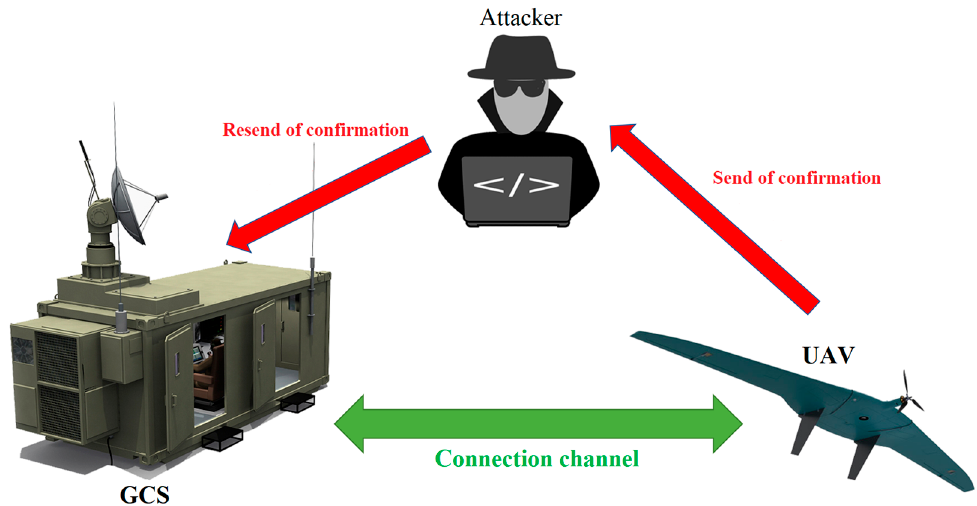
Figure 6. Scheme of the “man in the middle” attack on UAV.